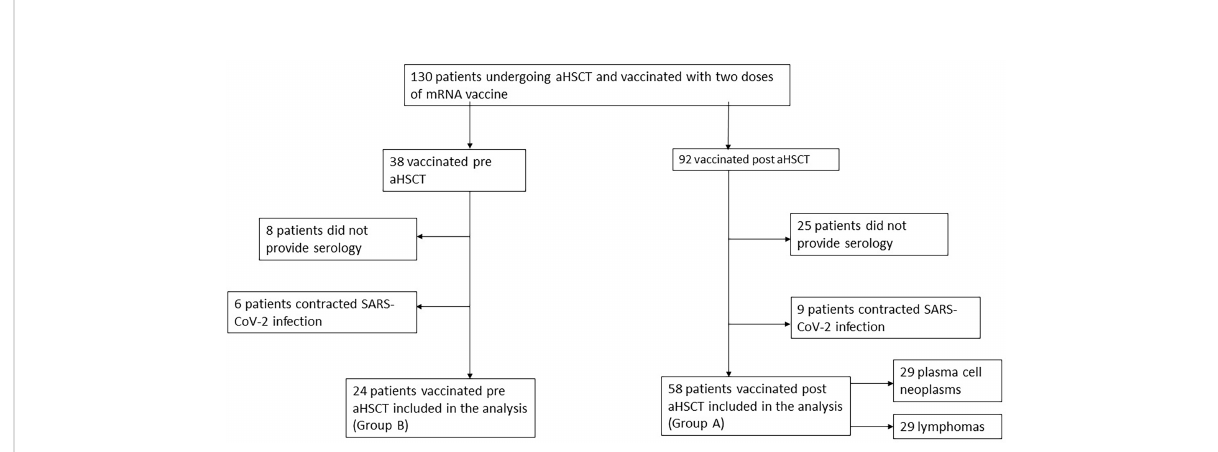
FIGURE 1 Flow diagram regarding the description of inclusion and exclusion criteria of the